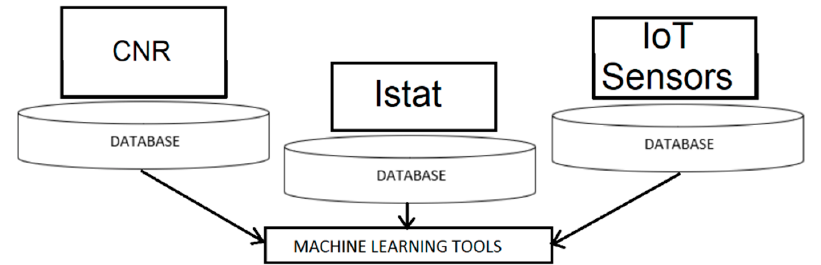
Figure 1. The datasets used for this study: National Research Council (CNR) scientific dataset, Istat statistical dataset, and the industrial Internet of Things (IoT) Sensors dataset.